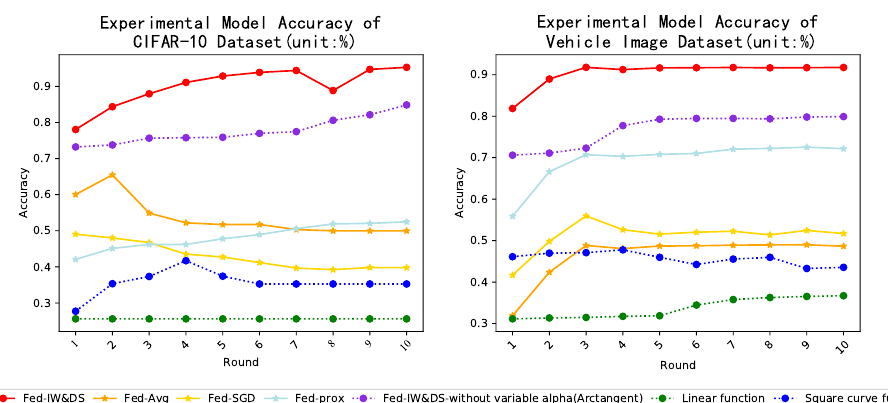
Figure 5. Comparison of Accuracy.